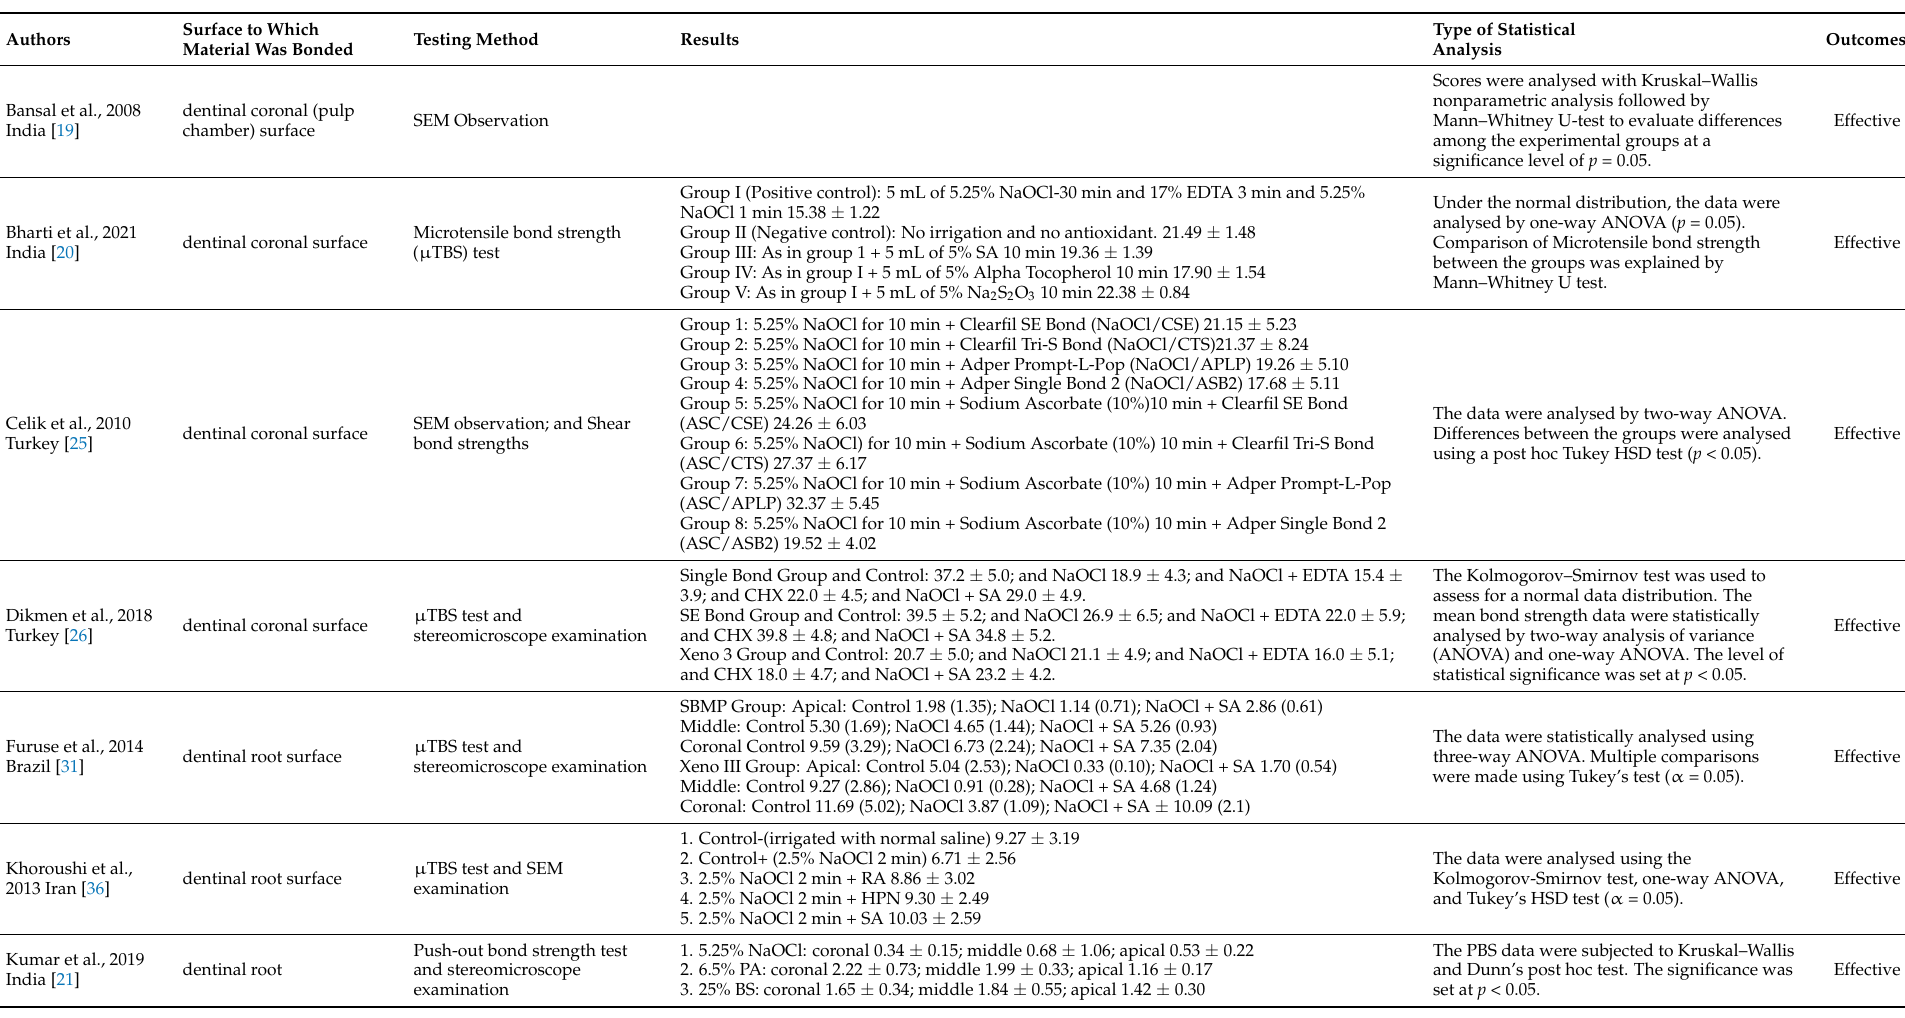
Table 4. Summary statistic for each